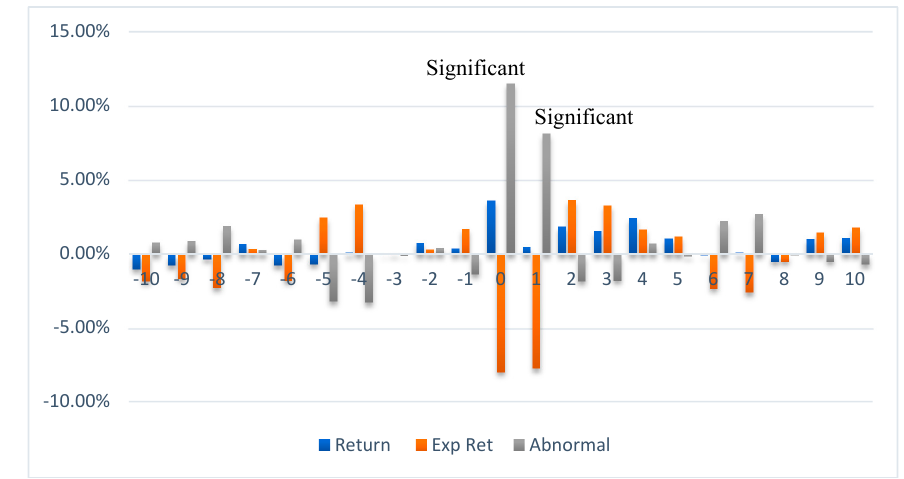
Figure 4. Emerging Equity ETF.